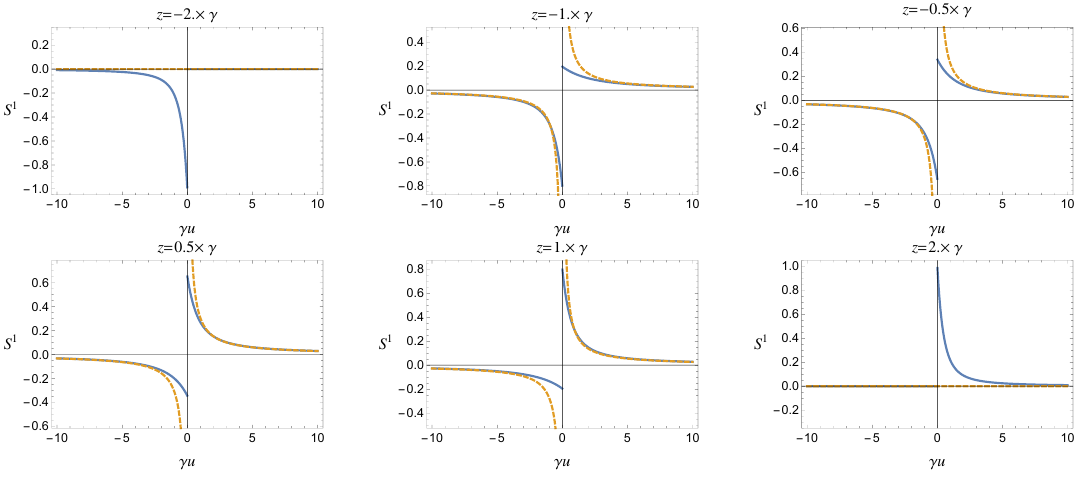
Figure 4 . The solid blue curves are the numerical Fourier transforms of (5.6), S 1 ( u ), u (cid:17) (cid:28) (cid:0) (cid:28) 0 , while the dashed orange curves represent the large time separation approximations S 1 For j z j < 2 (cid:13) , S 1 ( u ) matches the late time behavior of the numerical Fourier low